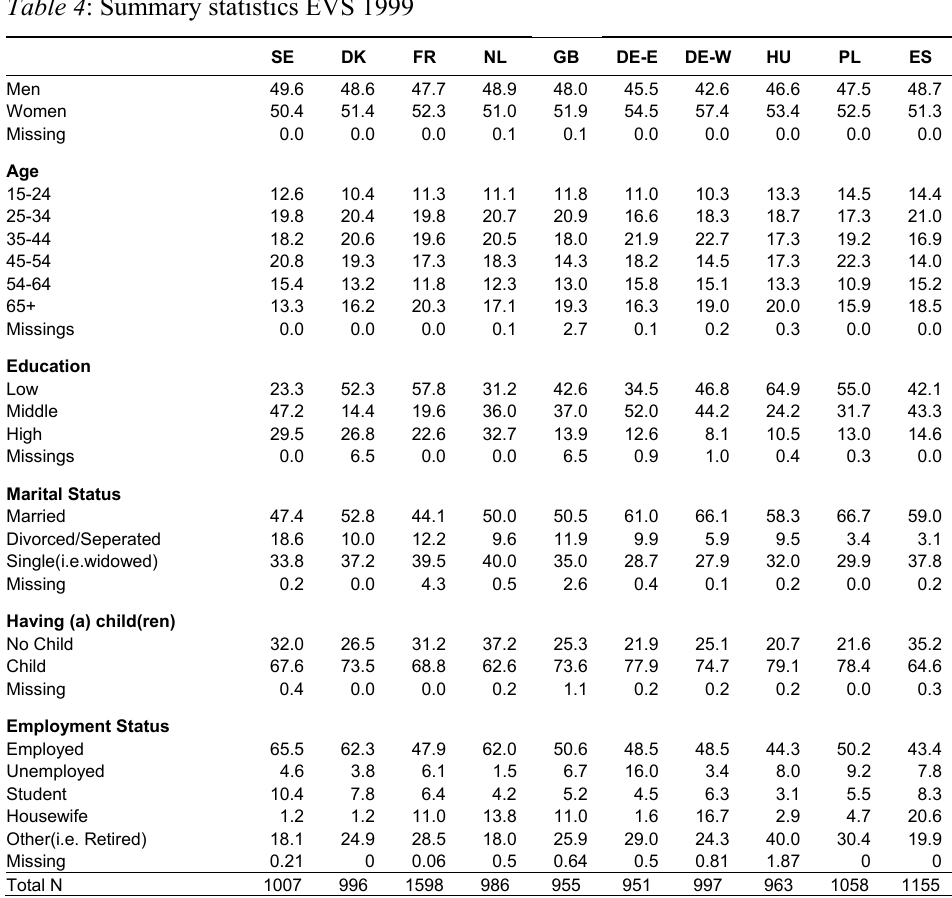
Table 4 : Summary statistics EVS